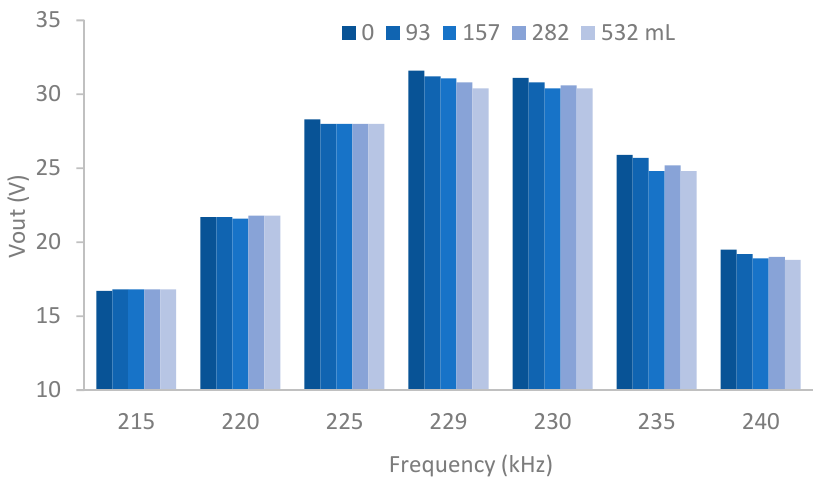
Figure 8. Vout of P5 using samples with different water content.